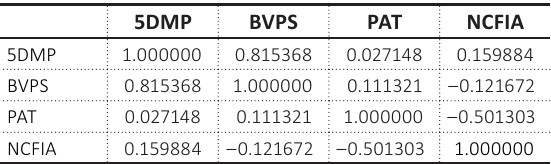
Table 4. Pearson correlation, post-Ind AS